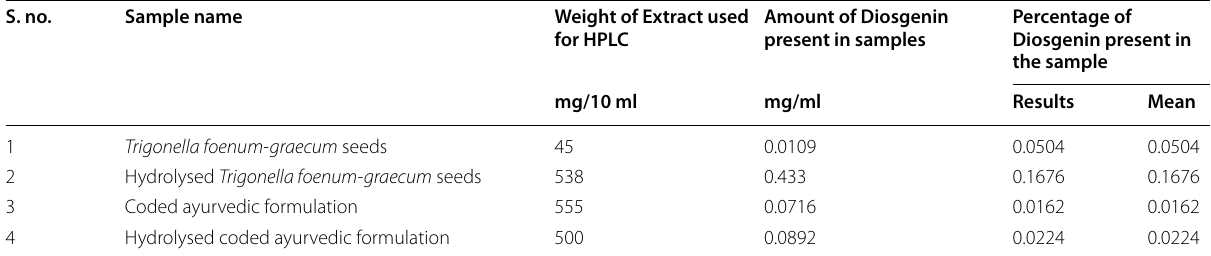
Table 2 Estimation of Diosgenin biomarker compound in coded ayurvedic formulation and Trigonella foenum-graecum seed S.